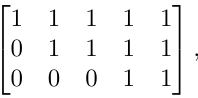
Figure 1: Two implementations of ( y 0 , y 1 , y 2 ) T = A × ( x 0 , x 1 , x 2 , x 3 , x 4 )